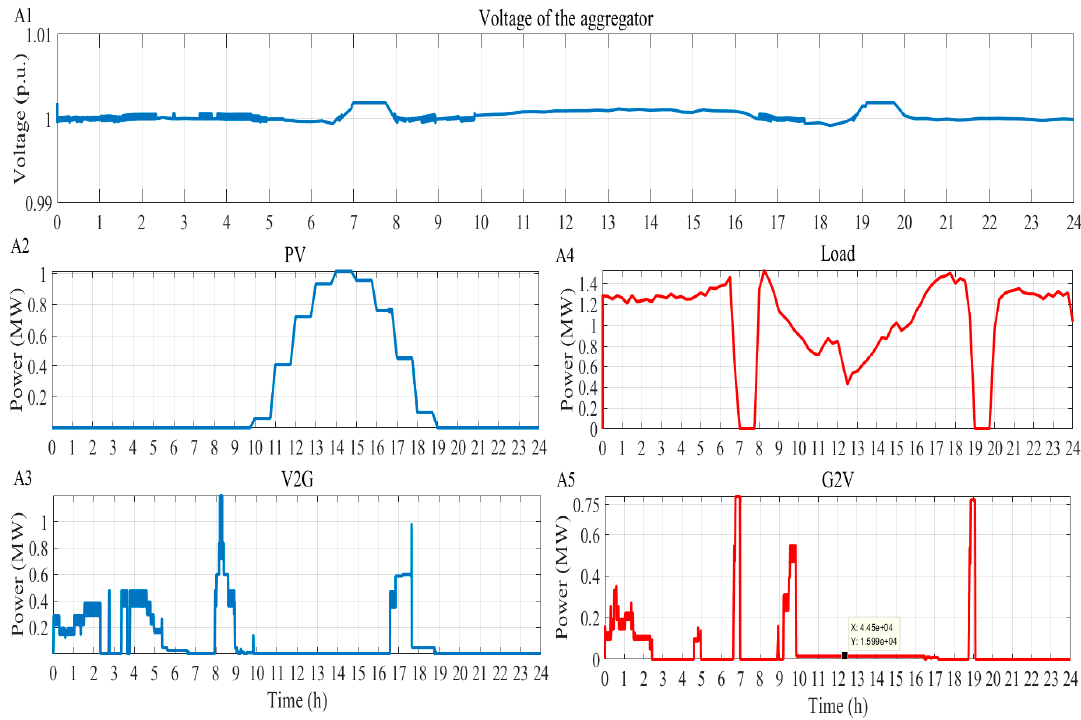
Figure 9. Time-based active power and voltage profile through the architecture (Scenario A): ( A1 ) voltage profile of the aggregator, ( A2 ) generated active power from PV, ( A3 ) injected active power from the aggregator (V2G), ( A4 ) Demand side, ( A5 ) the drawn active power from the architecture to the aggregator (G2V).